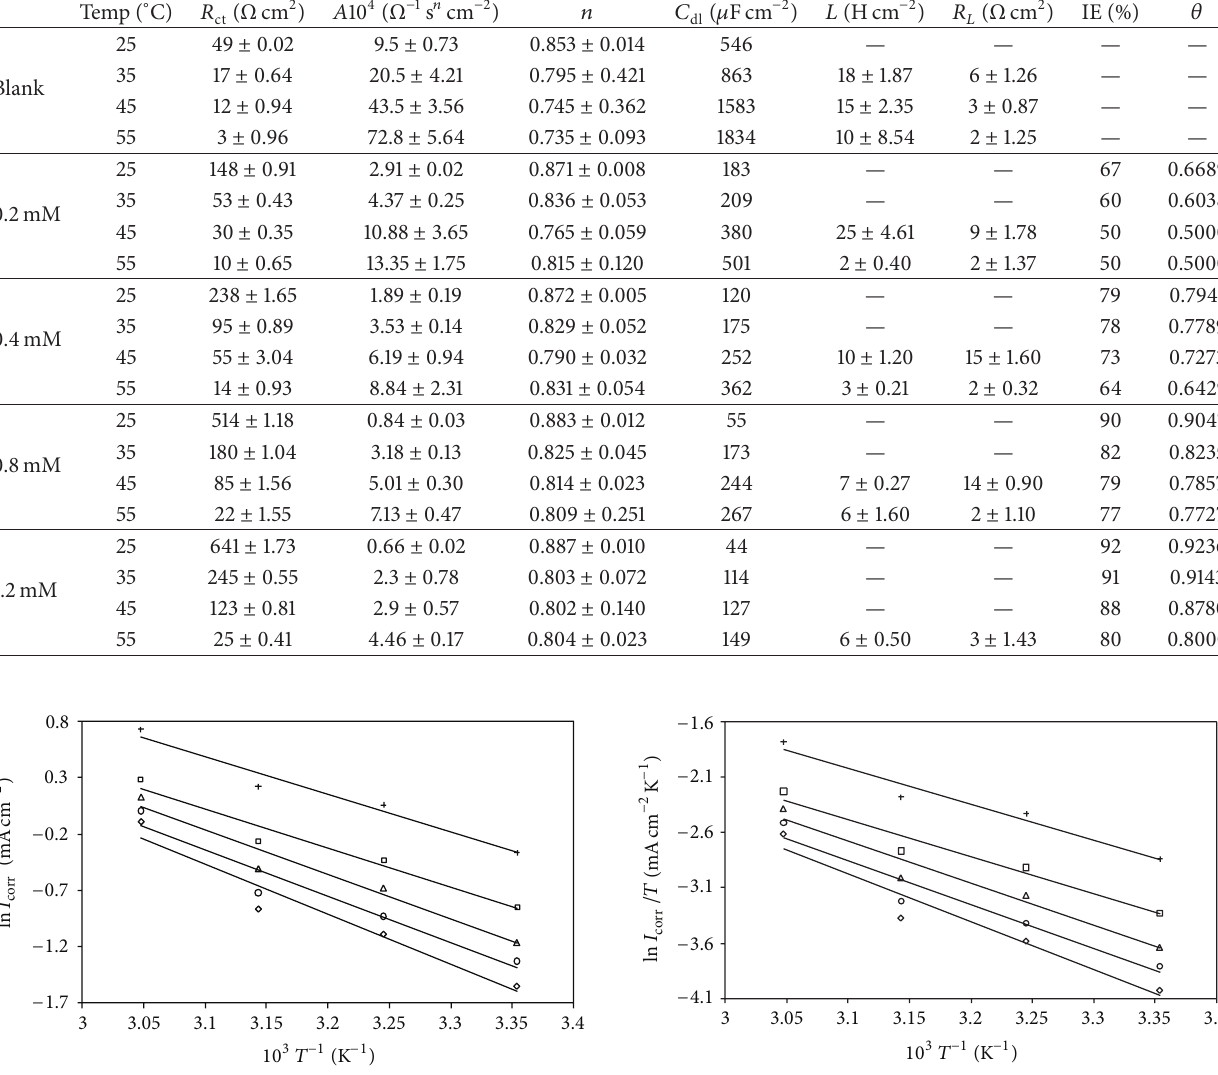
Table 4: Values of the elements of equivalent circuit required for fitting the EIS for C38 steel immersed in the presence and absence of norharmane at different temperatures.